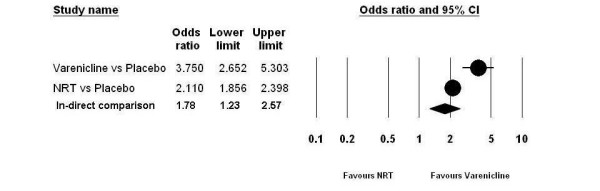
Indirect comparison between Varenicline and NRT vs Placebo at 3 months. Bucher et al. indirect comparison methods [28].